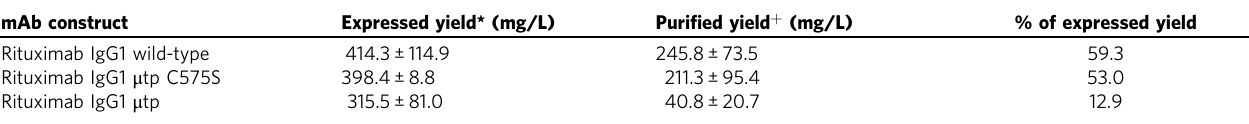
Table 1 Estimated expression yield and calculated puri fi ed yield for rituximab IgG1 μ tp constructs. mAb construct